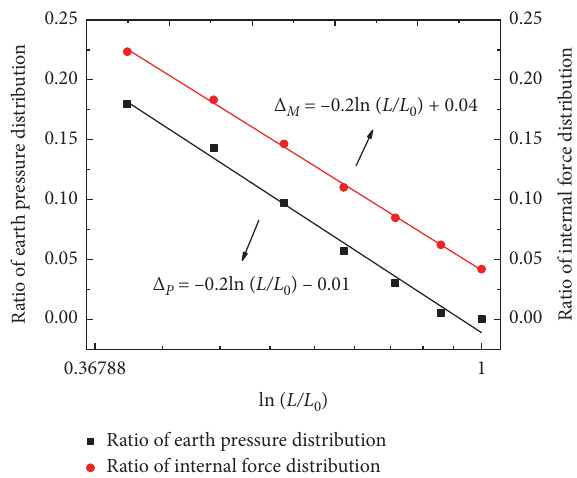
Figure 11: Relation curve of Δ